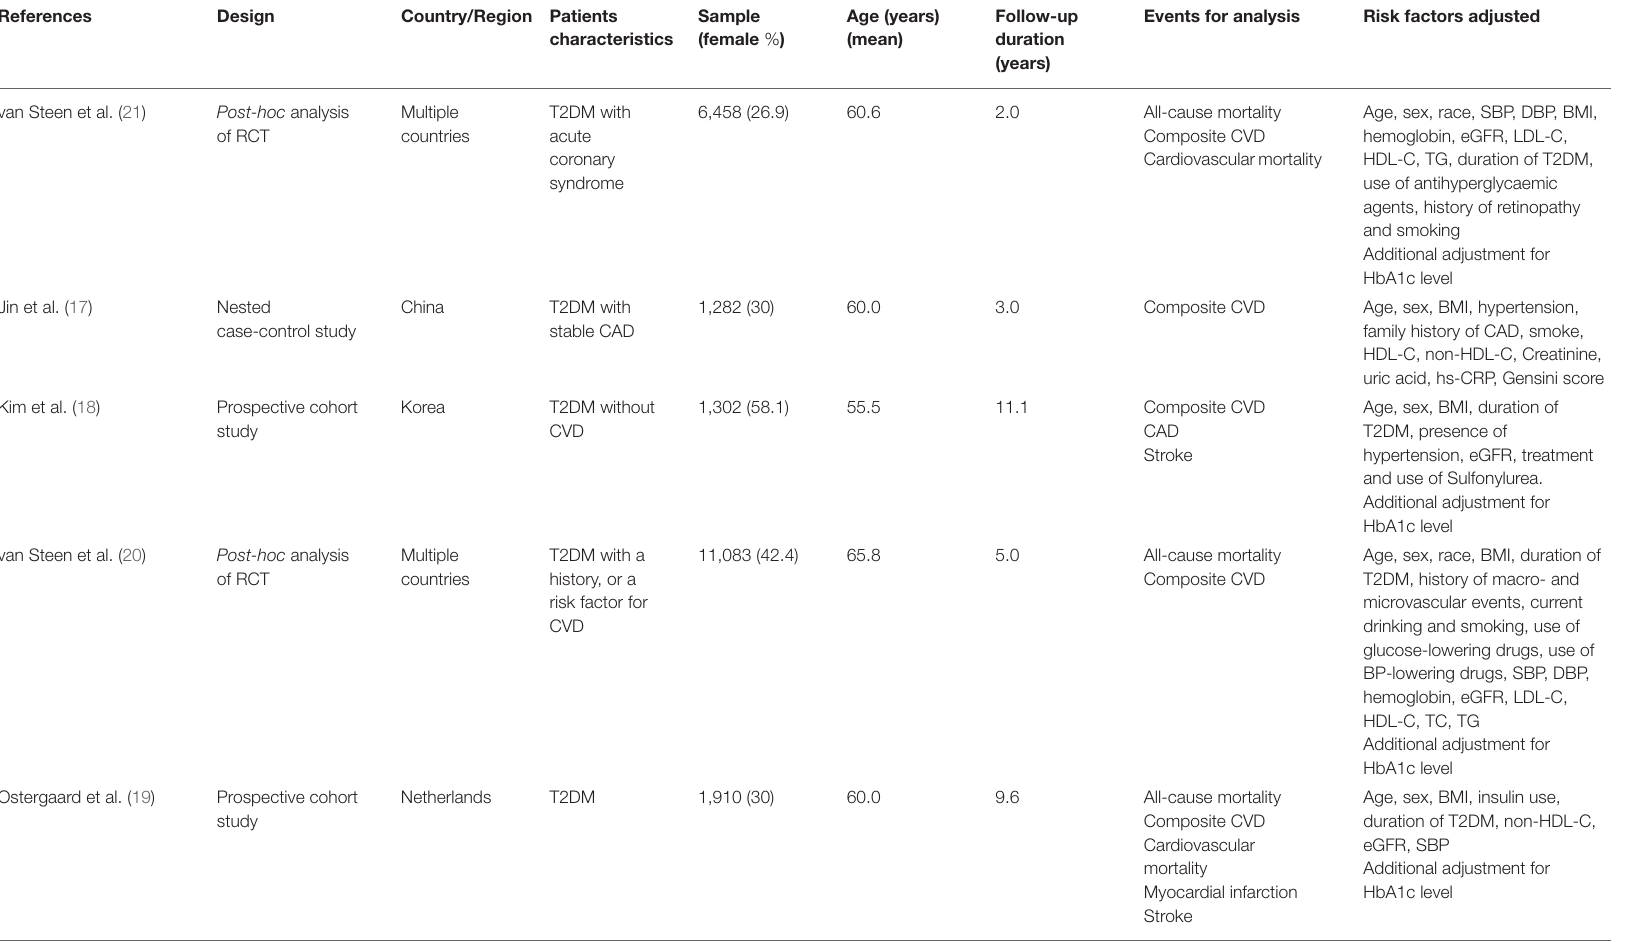
TABLE 1 | Characteristics of the included